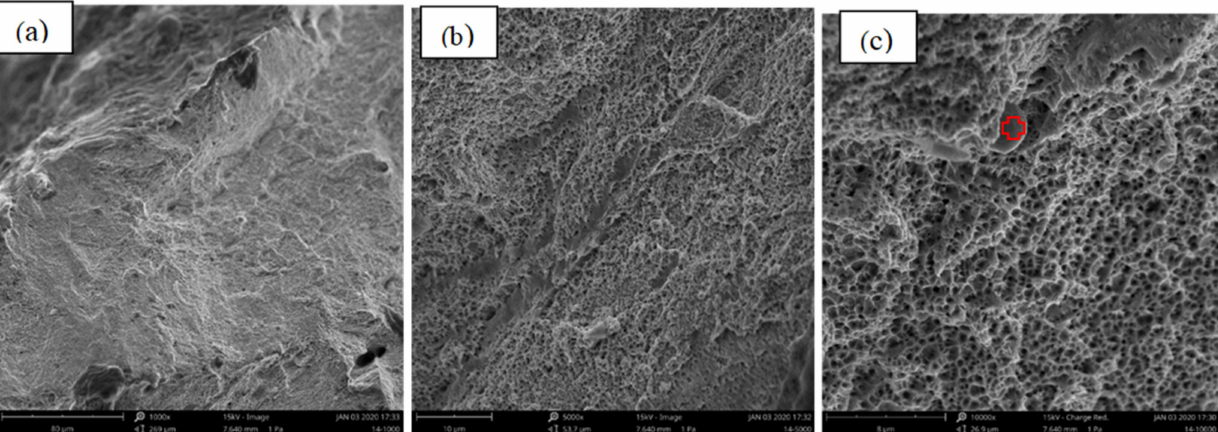
Figure 10. The fracture morphology of group 14—Low Tensile Strength in Table 4, ( a ) × 1000, ( b ) × 5000, ( c ) × 10,000 (circled area represents the EDS performed zone).